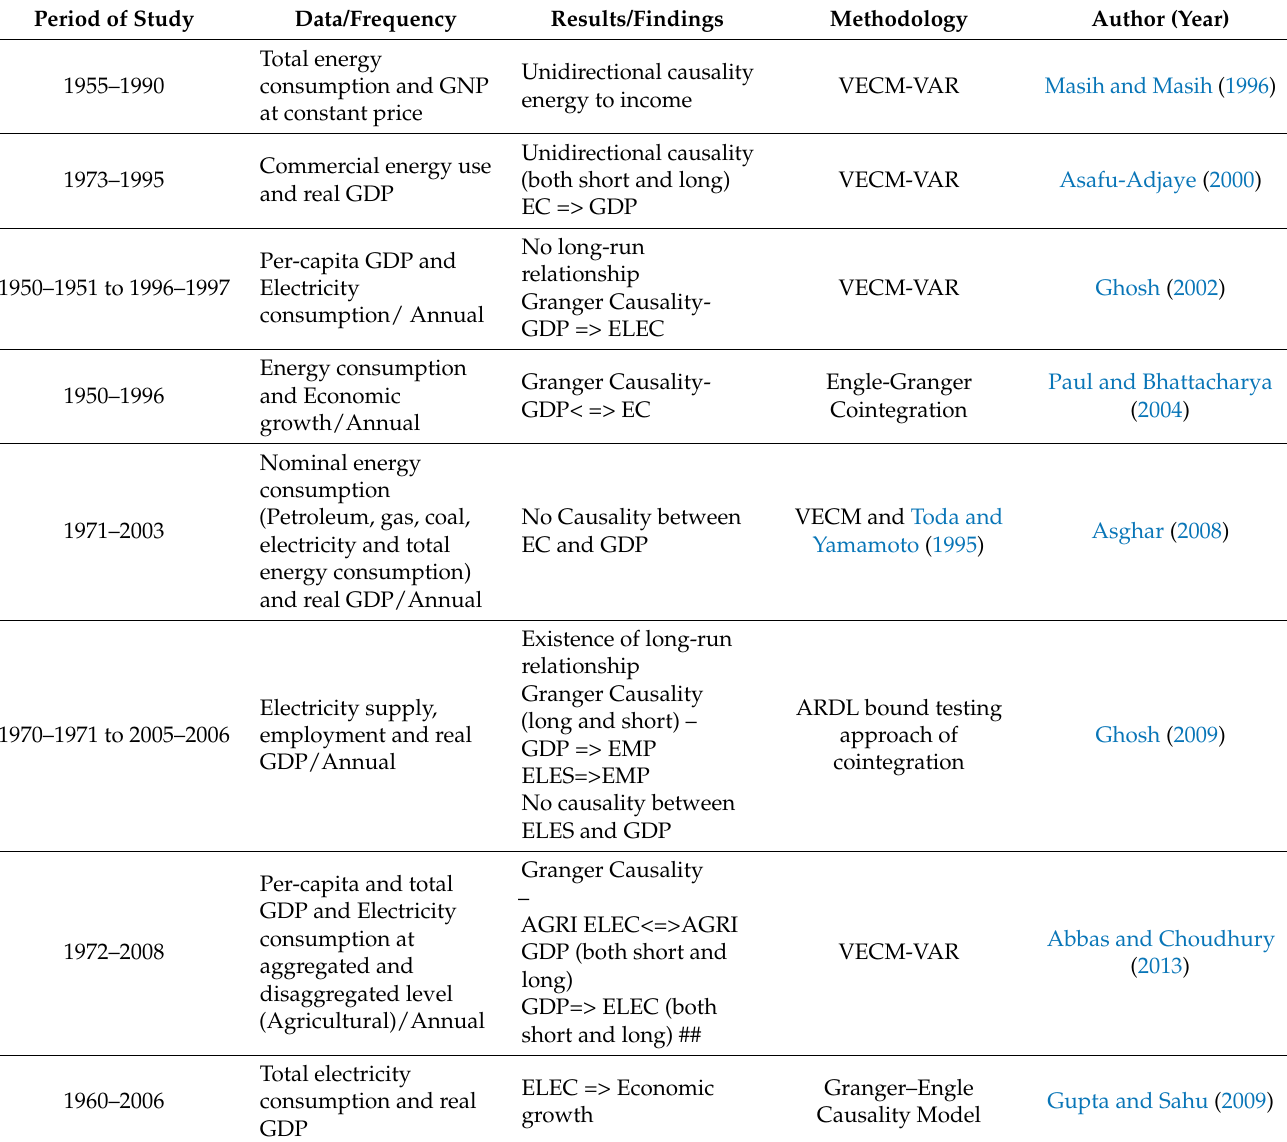
Table 1. Summary of the Indian Literature on Causality between Electricity Consumption and Economic